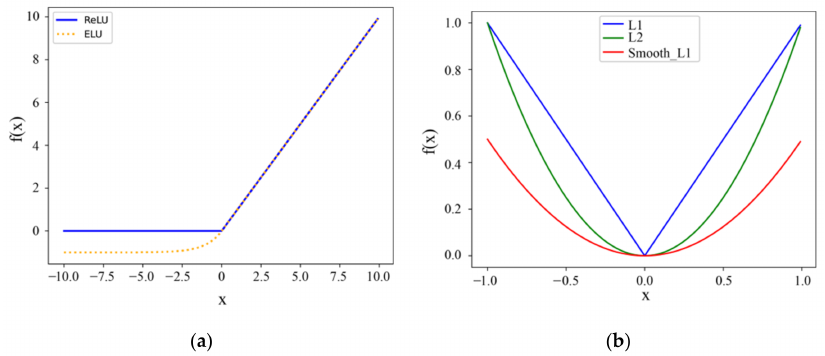
Figure 2. Activation functions ( a ) and Loss functions ( b ). For ( a ), f ( x ) is ELU ( x ) or ReLU ( x ); for ( b ) f ( x ) is L 1 ( x ) , L 2 ( x ) or SmoothL 1 ( x )